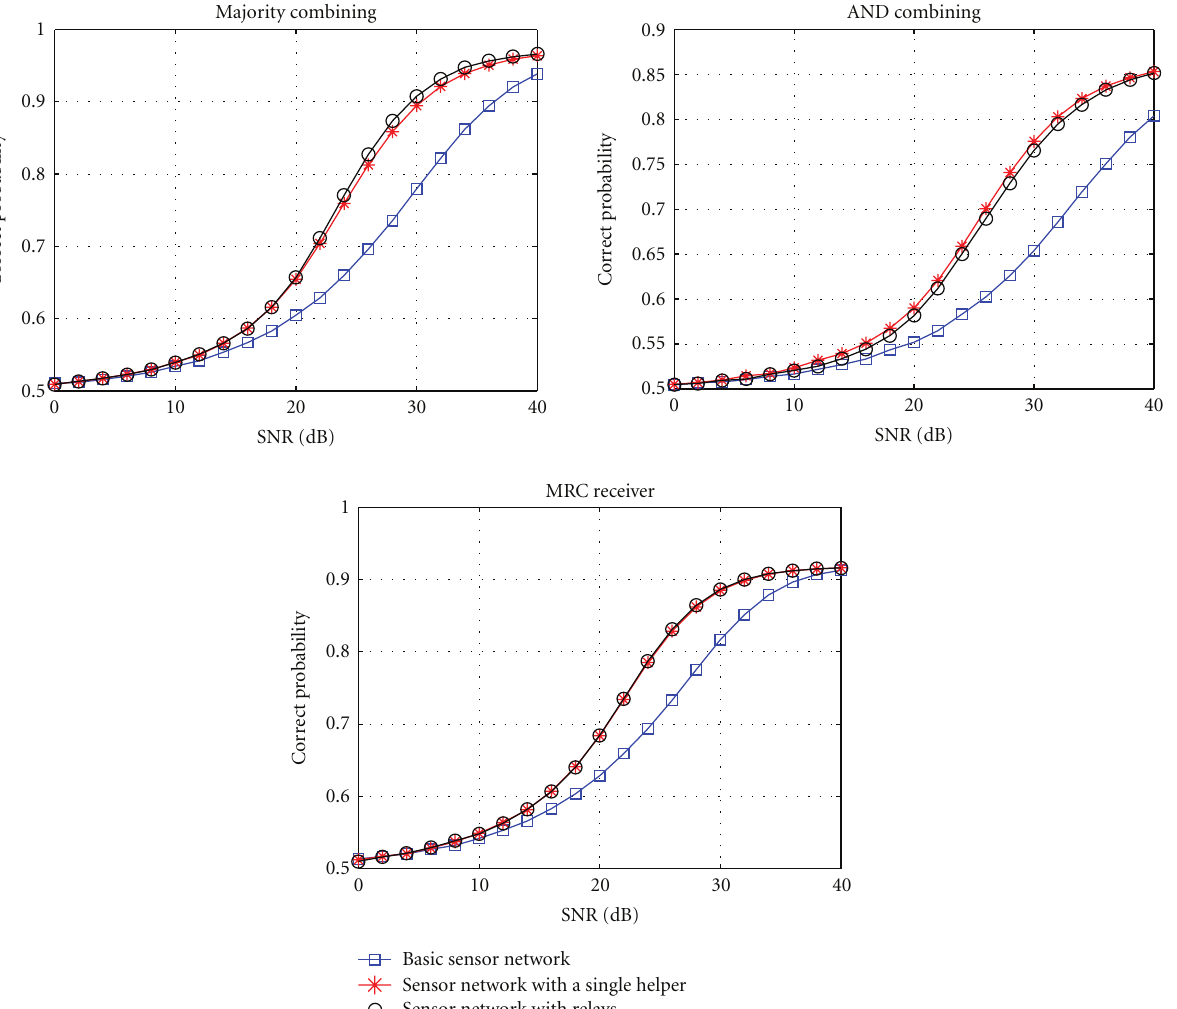
Figure 9: Simulated correct probability in three networks with optimized locations of the intermediate fusion helper and relays in Rayleigh fading channels ( A = 0 . 9, β = 3 . 5, d =